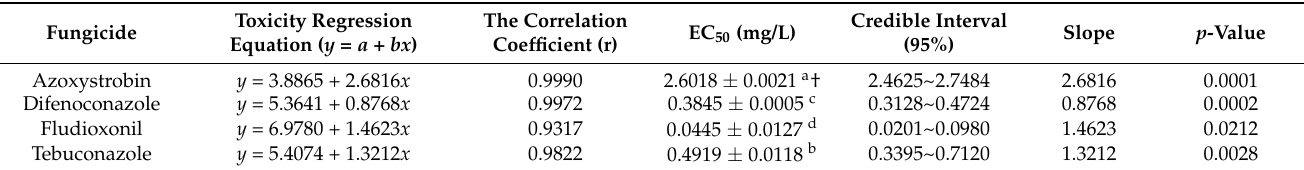
Table 1. The EC 50 values and the regression equation of the four tested fungicides to the mycelial growth of F. pseudograminearum .